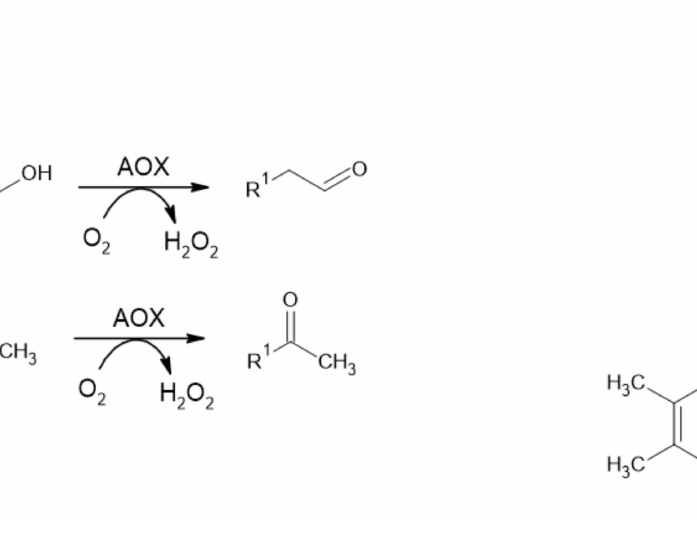
Figure 3. Reaction catalyzed by AOX and its cofactor